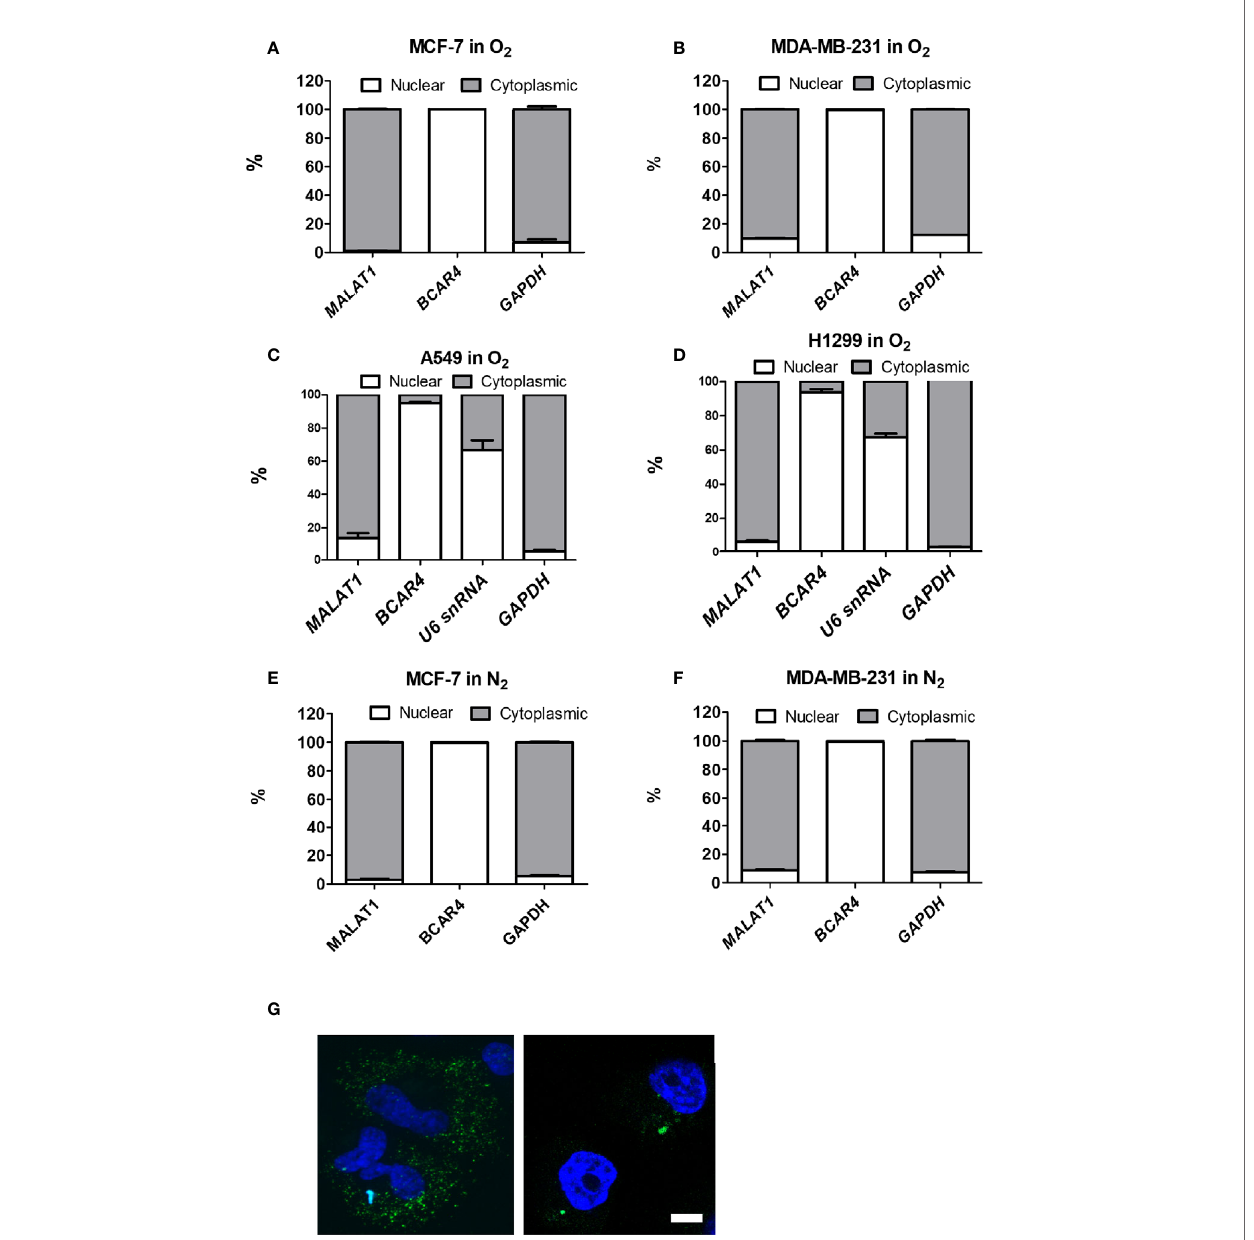
FIGURE 3 | MALAT1 is located primarily in the cytoplasm of MCF-7 and MDA-MB-231 cells under normoxia or hypoxia. (A – D) Cytoplasmic and nuclear distribution of MALAT1 in breast cancer cells [MCF-7 (A) , MDA-MB-231 (B) ] and lung cancer cells [A549 (C) , H1299 (D) ] cells under normoxia. (E, F) Cytoplasmic and nuclear distribution of MALAT1 in MCF-7 (E) and MDA-MB-231 (F) cells under hypoxia. Relative abundance of RNA was normalized to the total amount of RNA and detected by qPCR. BCAR4 and U6 snRNA: nuclear marker. GAPDH : cytoplasmic marker. Data shown are the means ± SDs (n=3). (G) RNA FISH of MALAT1 . Cell nuclei were stained by Hoechst staining (blue). MALAT1 was hybridized with MALAT1 -FITC probes (green) in breast cancer cell lines and detected by a Zeiss LSM880 microscope. Magni fi cation:1,000×; Scale bar: 5 m